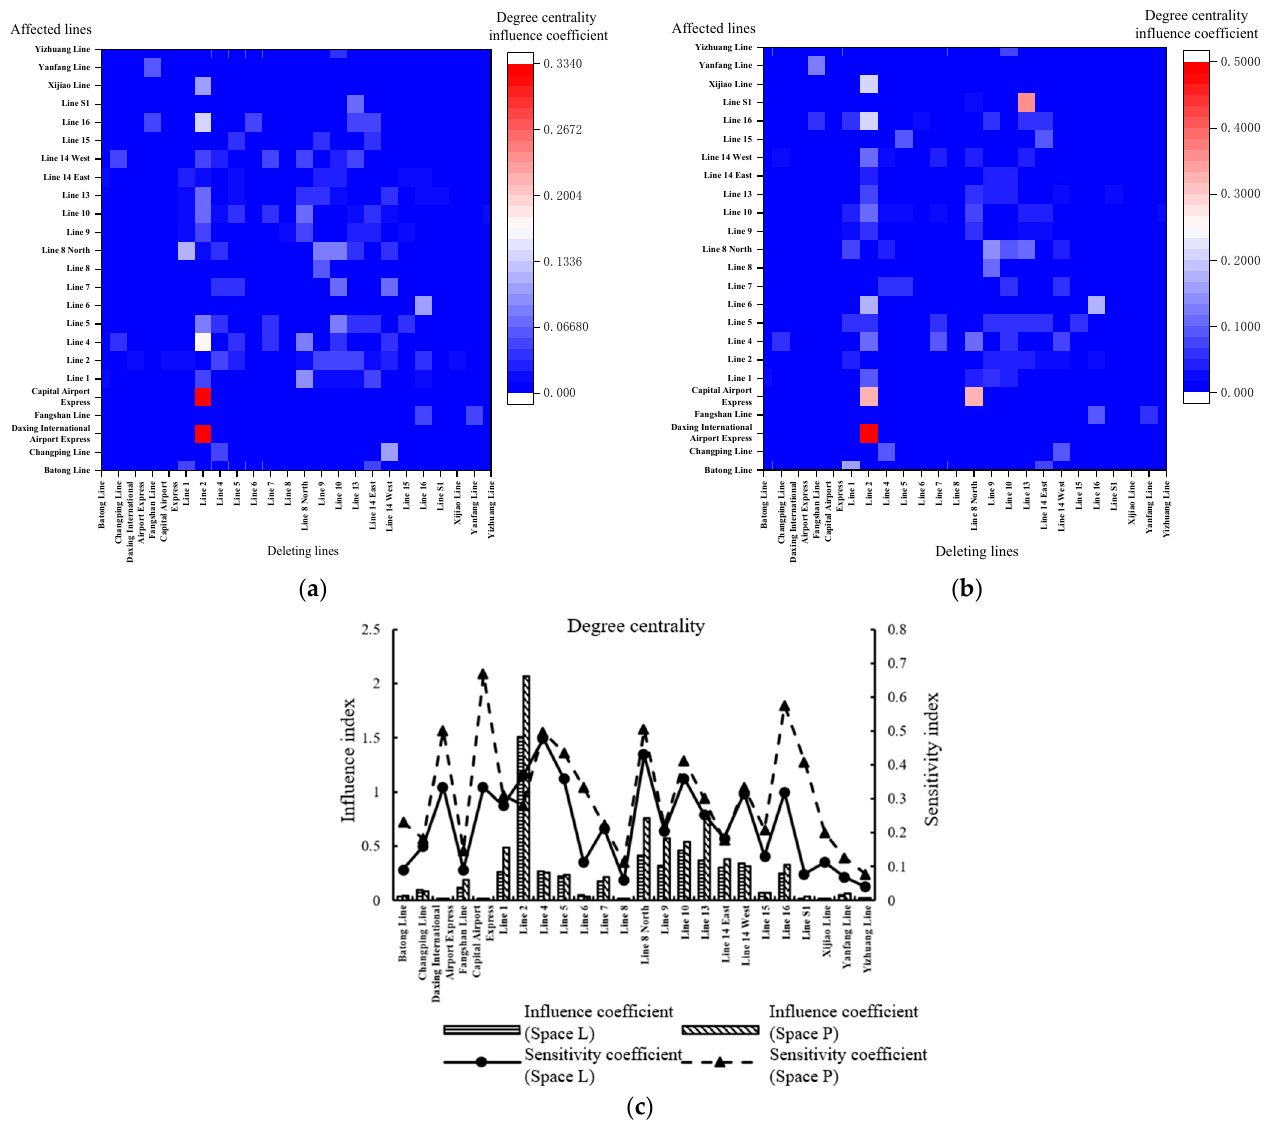
Figure 8. Degree centrality influence and sensitivity coefficient. ( a ) Degree centrality influence coefficient between lines (Space L). ( b ) Degree centrality influence coefficient between lines (Space P). ( c ) Degree centrality influence and sensitivity coefficient.